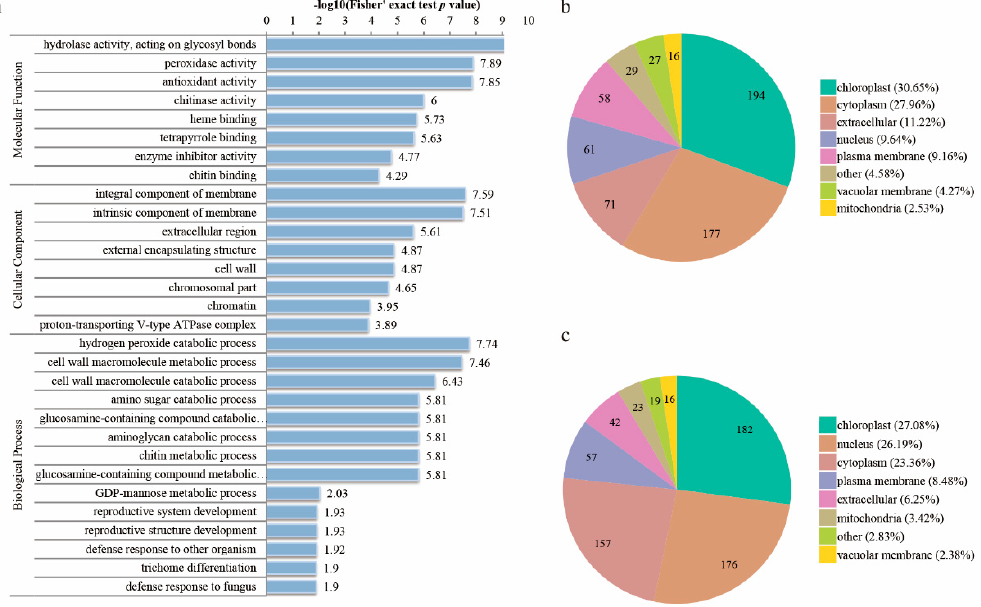
Figure 4. GO enrichment analysis and subcellular localization chart of DEPs in the control and the FB1 samples. ( a ) GO enrichment analysis of DEPs in control and the FB1 sample. ( b ) Subcellular localization chart of the up-regulated proteins. ( c ) Subcellular localization chart of the down-regulated proteins.